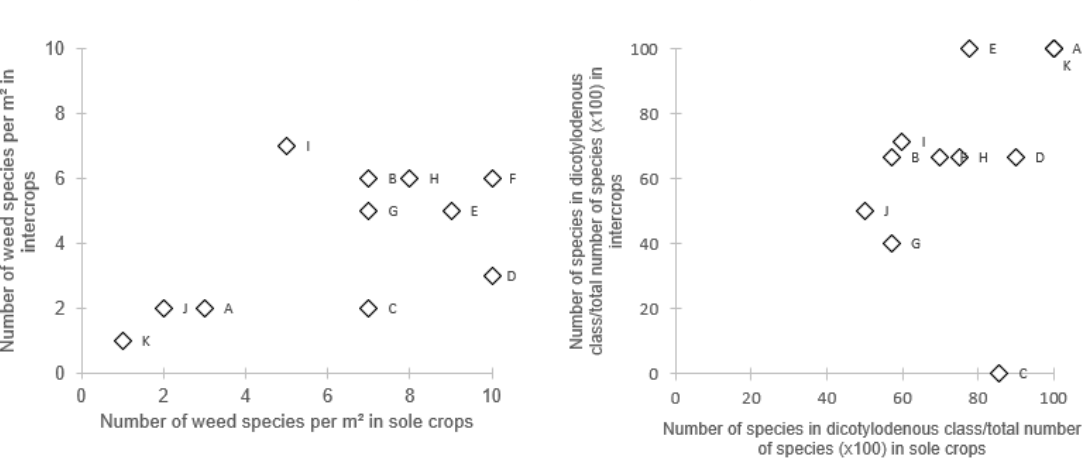
Figure 6. Weed growth after flowering against crop biomass at lupin flowering. Open symbols refer to lupin sole crops and full symbols refer to intercrops. Letters next to points identify study sites.